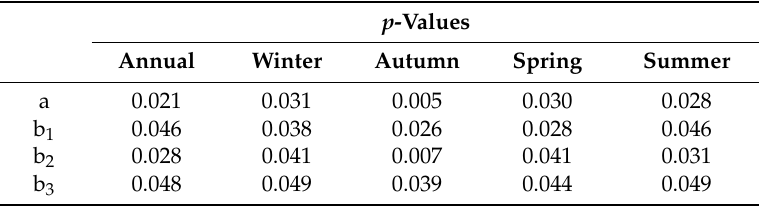
Table 7. Output p -values of the examined